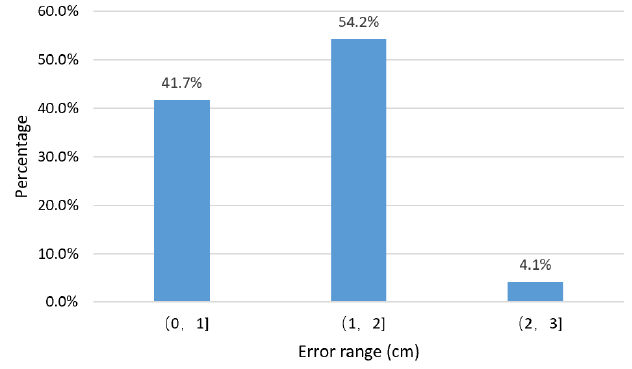
Figure 14. Positioning error distribution.